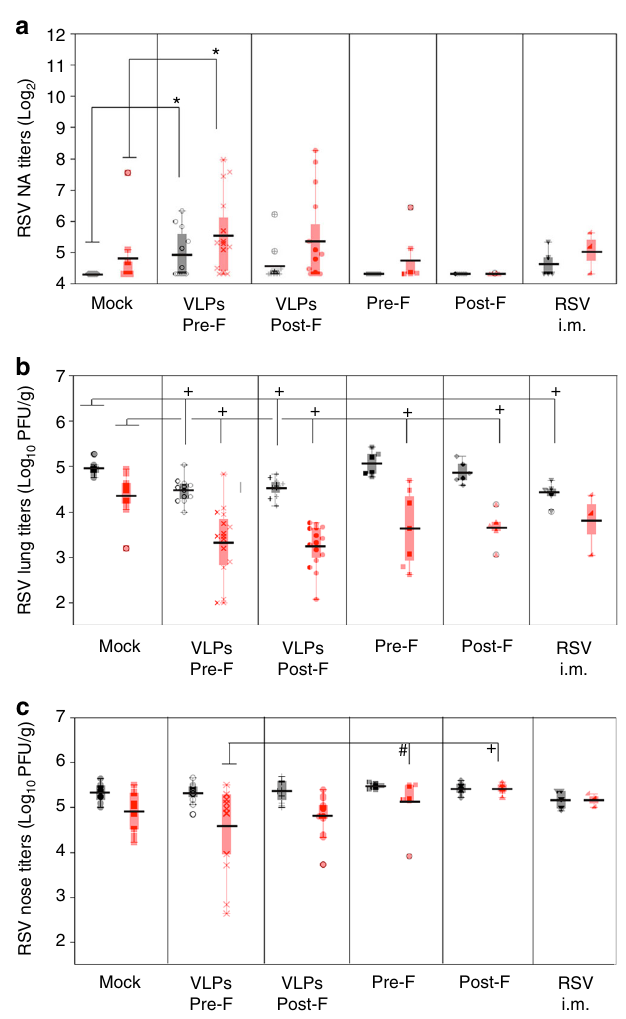
Fig. 5 Ef fi cacy of protection of offspring by maternal immunization with VLPs. a RSV neutralizing antibodies measured in 4-week-old litters derived from the indicated groups of unprimed (black symbols) or RSV-primed (red symbols) dams. Each symbol represents the mean of each litter. Boxes represent the boundaries of the quartiles Log 2 NA titers obtained for all litters in a group. Error bars represent s.e.m. Comparison of the responses between the respective mock-vaccinated groups and VLPs or RSV i.m.- vaccinated groups was assessed by non-parametric Kruskal – Wallis test. * p < 0.05. b Mean litter lung and c nose viral titers in RSV-challenged 4-week- old pups measured on day 4 post infection. Each symbol represents the mean viral titer in each litter. Horizontal lines represent the mean for each group. Boxes represent the boundaries of the quartiles values for each group. Error bars represent s.e.m. Comparison of the protection achieved between the respective mock-vaccinated group and VLPs or RSV-i.m.- vaccinated groups was assessed by one-way ANOVA followed by Tukey post hoc test. + p < 0.0001; # p <